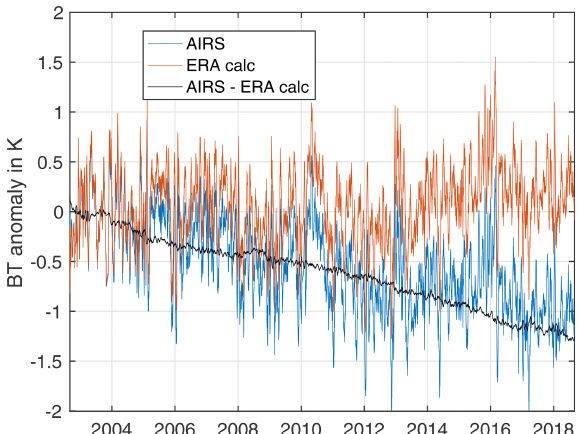
Figure 5. Sample AIRS observed and ERA-I simulated BT anoma- lies for the zonal bin centered at 28.3 ◦ N for the AIRS channel centered at 710.14cm − 1 . The differences in the AIRS and ERA- I anomalies are plotted in black. Note that this difference anomaly is not used in the anomaly